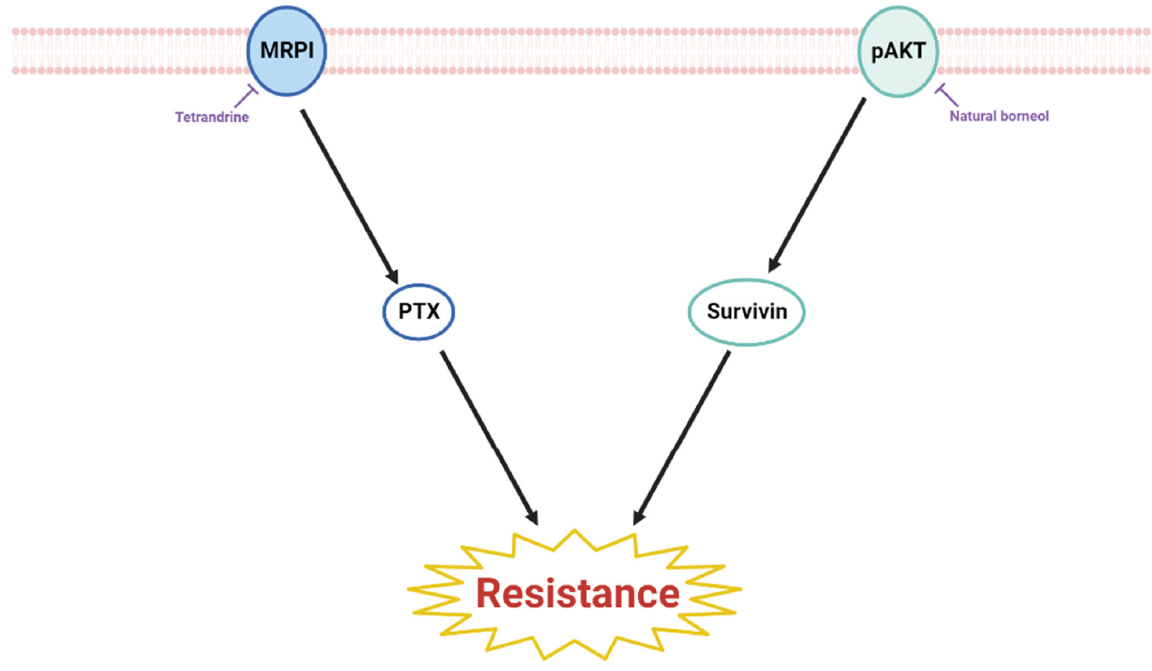
Figure 4. Schematic diagram of resistance ‐ sensitizing natural products in esophageal cancer.